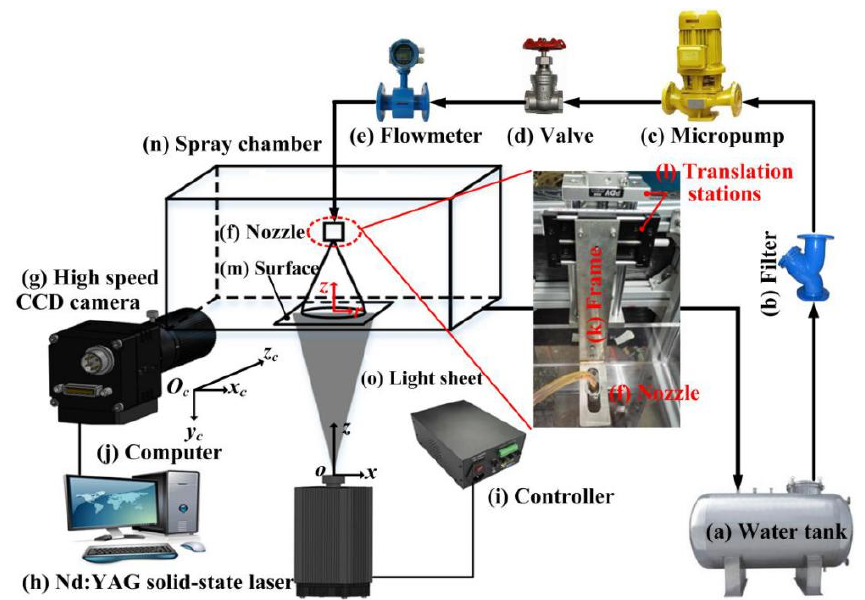
Figure 1. Experimental setup of studying the film formation with the pressure-swirl nozzle.